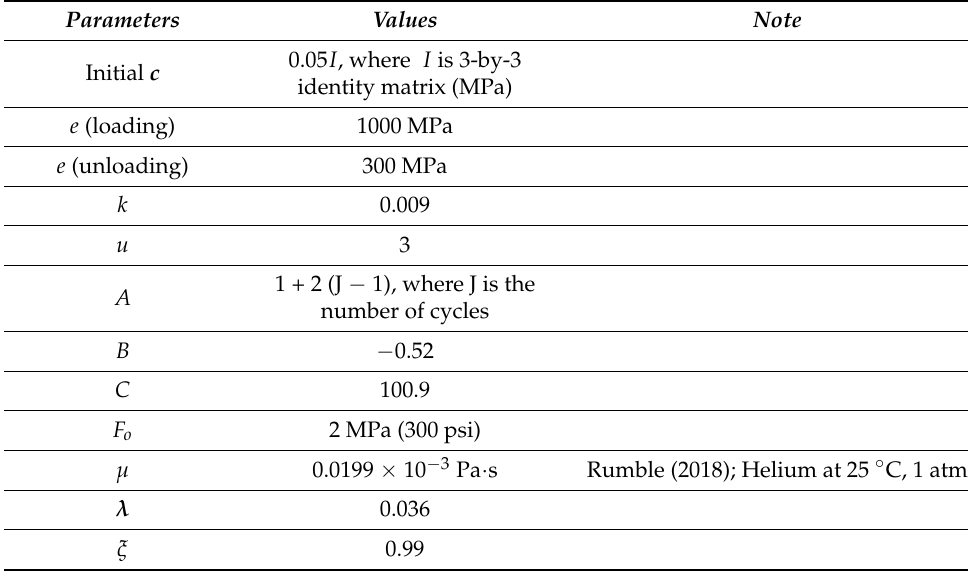
Table A7. Values of different parameters for sample 4 (test